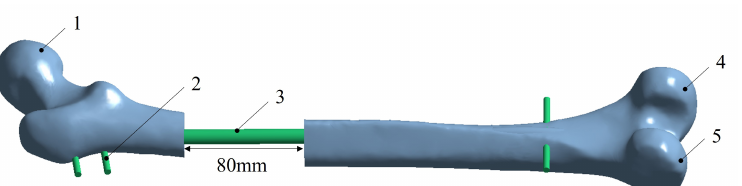
Figure 7. Boundary condition applied in FEA. 1—femoral head, 2—bone screw, 3—implantable lengthening nail, 4—medial condyle, 5—lateral